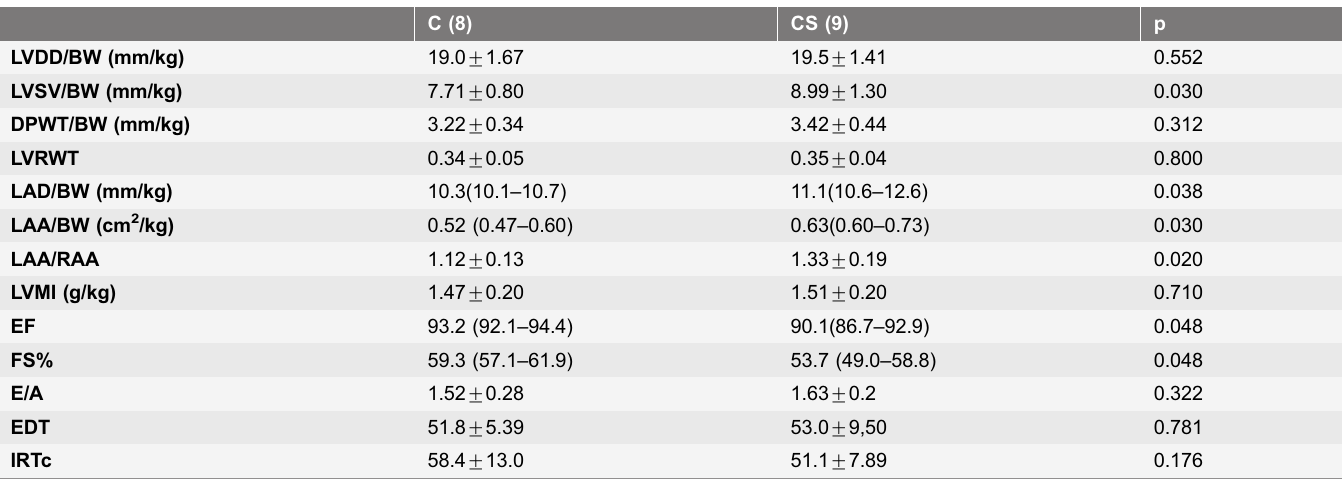
Table 1. Echocardiographic data.